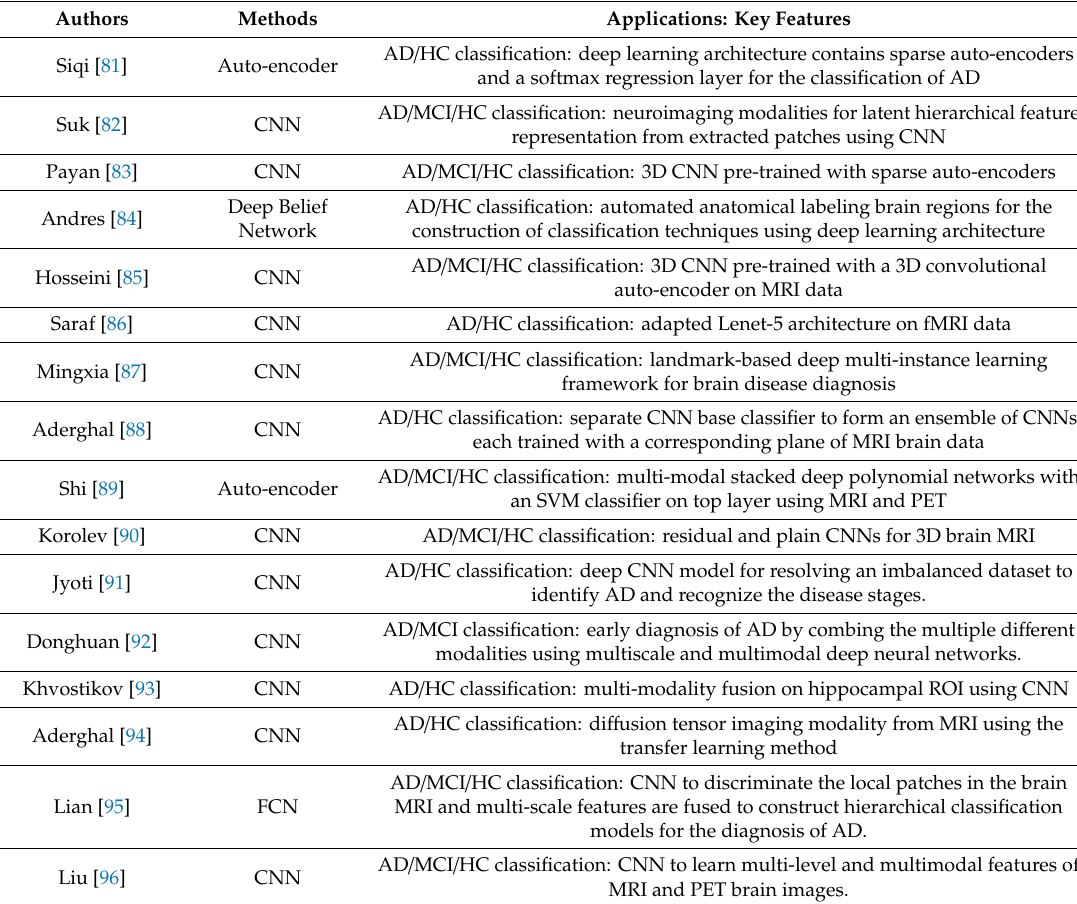
Table 6. Overview of existing methods using deep learning for the classification of AD. Authors Applications: Key